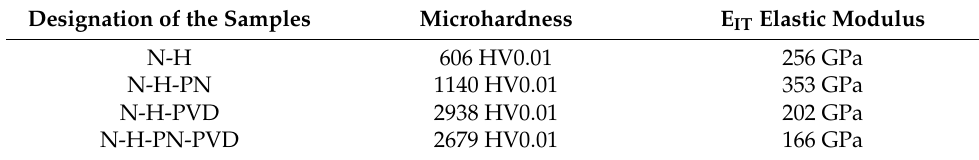
Figure 4. The loading-unloading test results carried out on ( a ) N-H-PN ( b ) N-H-PVD and ( c ) N-H-PN-PVD. Table 3. The measured hardness and the elastic